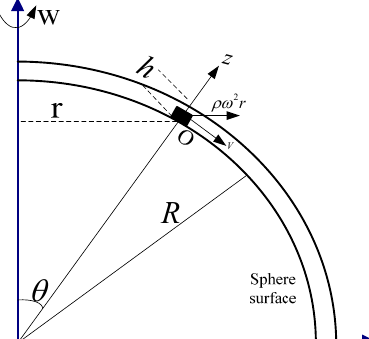
Figure 2. Schematic of spin coating on spherical surface. r is the horizontal distance from a position on the spherical surface to the vertical axis; θ is the central angle between a position on the spherical surface and the vertical axis; h is the film thickness at a specified position on the spherical surface; V is the tangential velocity of fluid at a position on the spherical surface; z is the distance from spherical surface along normal direction; R is the radius of the sphere; ω is the angular velocity of the sphere rotating along vertical axis.